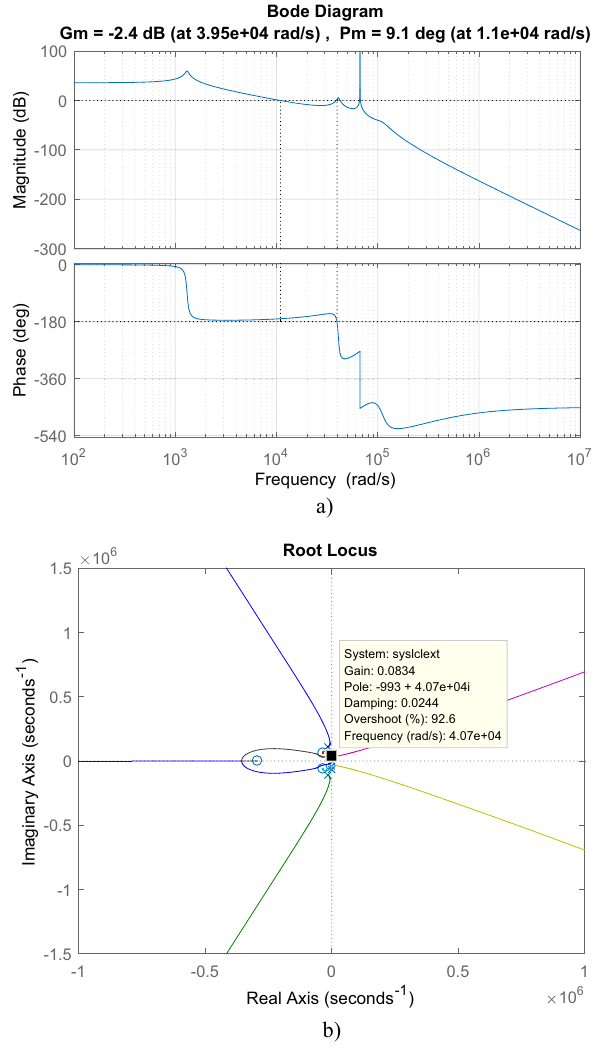
Figure 26. For LCL with parallel C DM filter with isolated Ćuk PFC ( a ) Bode diagram, ( b ) root locus.